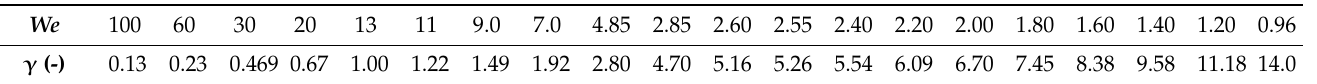
Table A2. Parameter settings (interfacial tension) corresponding to the simulated cases (see Table 1) in the dimensionless units used in the code. The dissipation rate of TKE (averaged over space and time) is 3.07 (-), and the initial drop diameter is 2 (-). The length of the simulation domain is 2 π